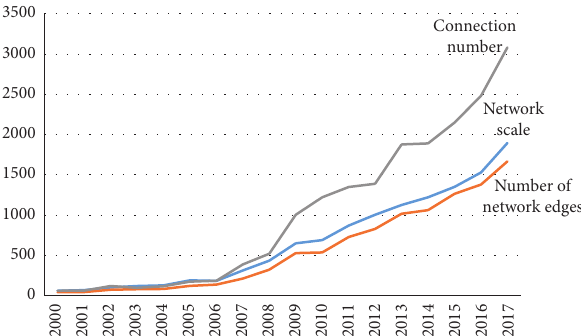
Figure 2: Scale evolution of China’s nonferrous metal collaborative innovation network. Figure 3: Density evolution of China’s nonferrous metal collab- orative innovation